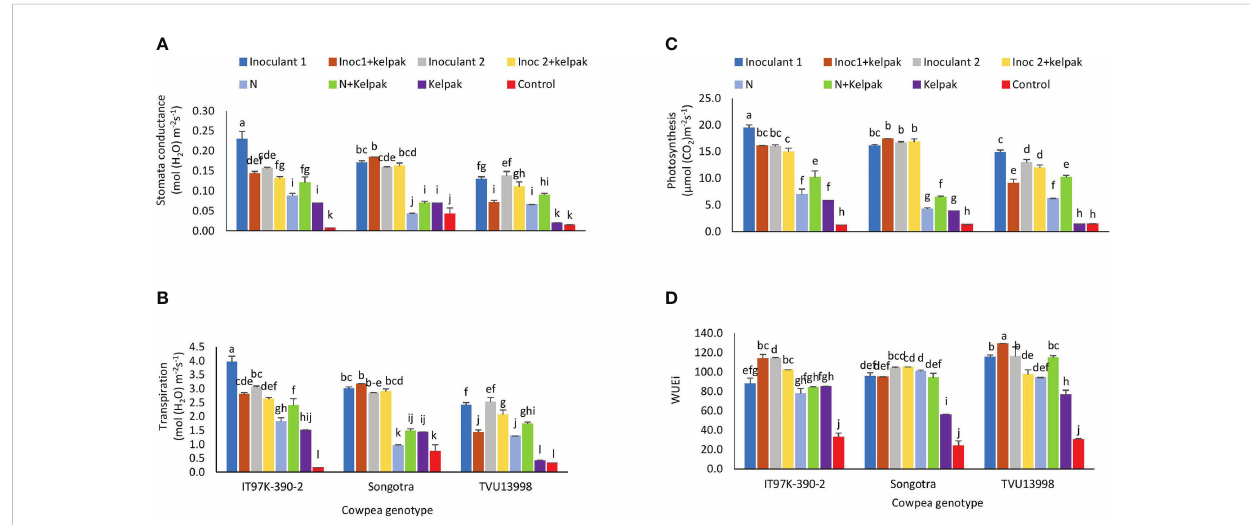
FIGURE 3 Interactive effect of genotype x treatment on stomata conductance (A) , transpiration (B) , leaf photosynthesis rates (C) and WUEi (D) of three cowpea genotypes, planted under glasshouse conditions. Inoculant 1(Inoc 1) = B . yuanmingense strain CB756 (commercial inoculant), Inoculant 2 (Inoc 2) = Bradyrhizobium sp. strain TUTVUSA (closely related to B . daqingense ), control = no inoculant and no kelpak, N= 5mM KNO 3, control= no inoculation and no kelpak. Vertical lines on bars represent S.E. Bars followed by dissimilar letters are signi fi cant at **p ≤ 0.01 or ***p ≤